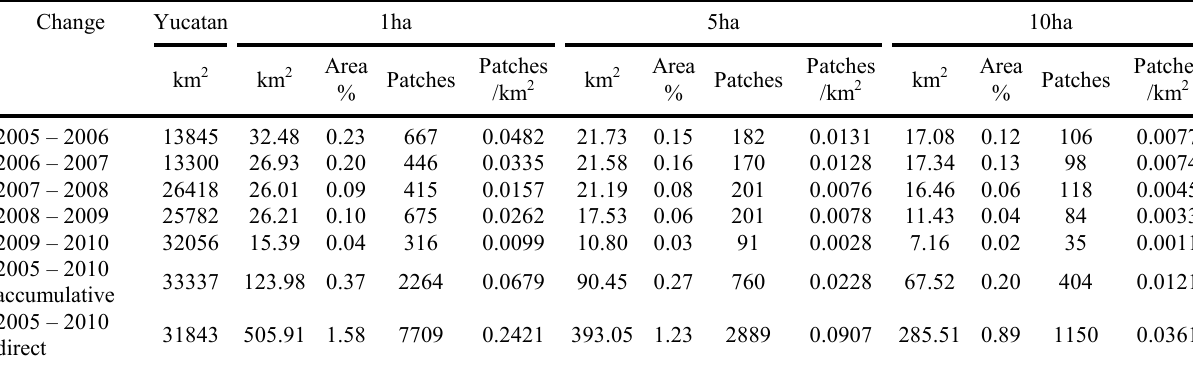
Table 5. Area and patches for changes of Landsat with 1ha, 5ha and 10ha minimum mapping unit for Yucatan. In comparison to area percentages at the national scale, MODIS